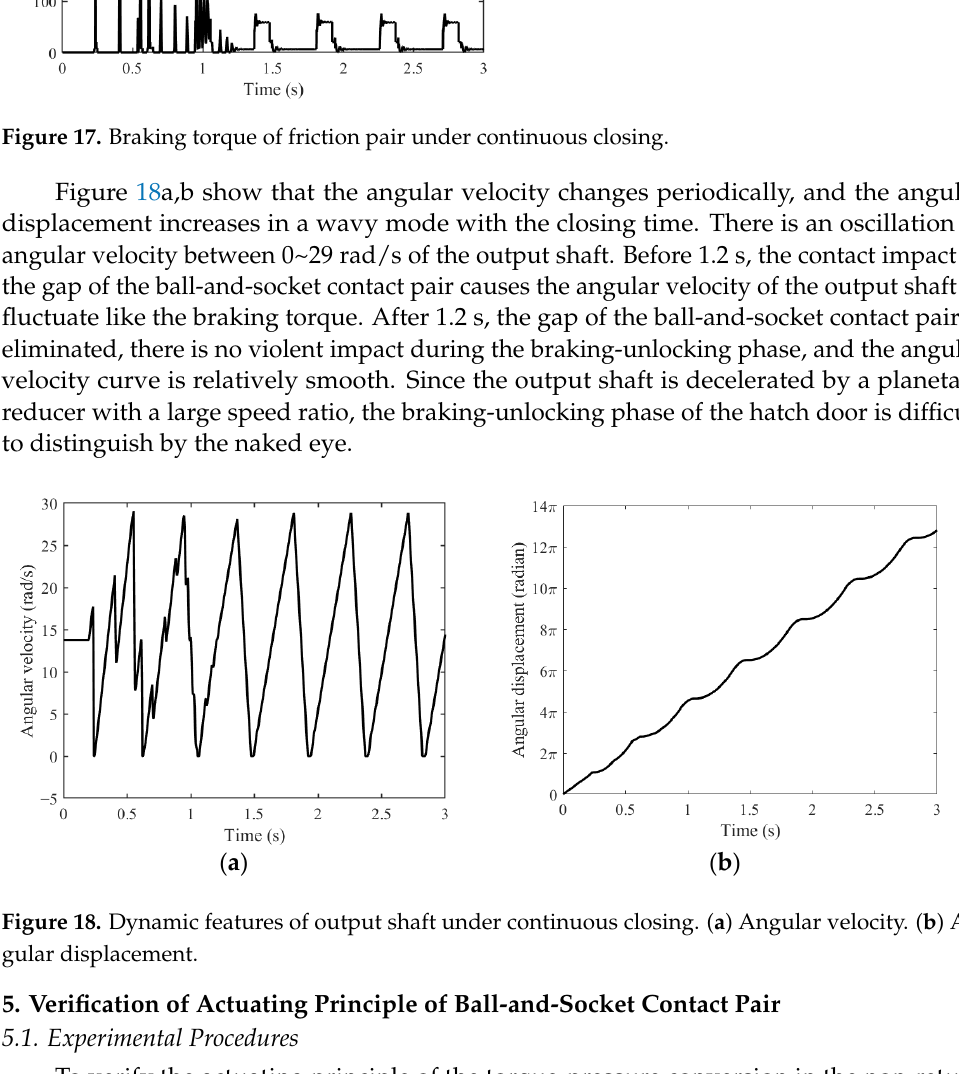
Figure 17. Braking torque of friction pair under continuous closing.